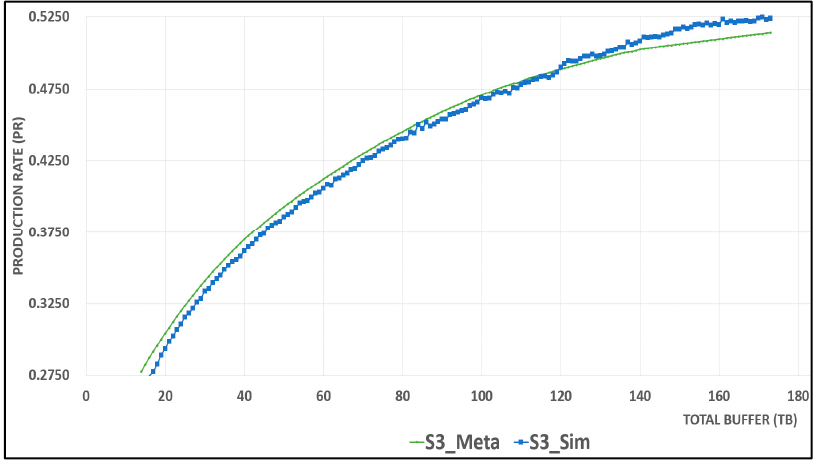
Figure 5. Comparison between meta-model and simulation (strategy 3). Table 9. Solution of BAP using CPLEX ® (strategy 3).